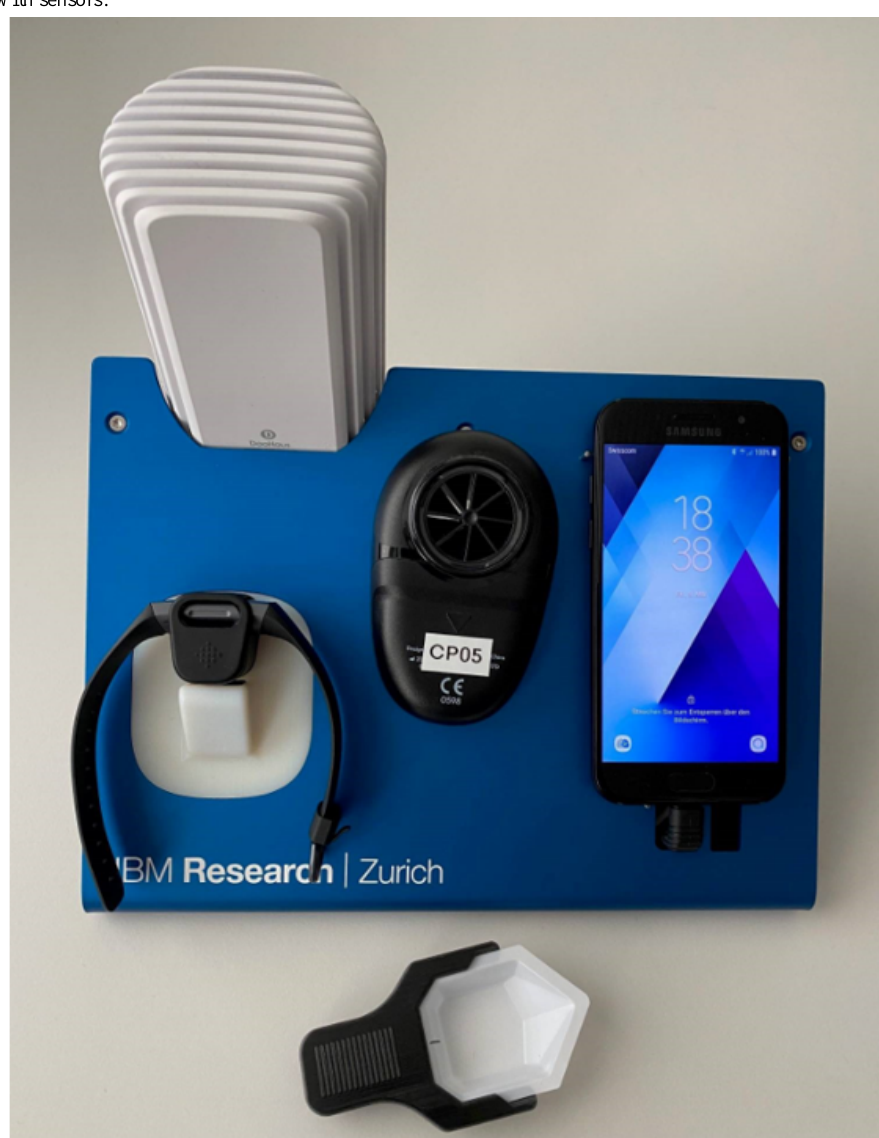
Figure 1. CAir Desk with